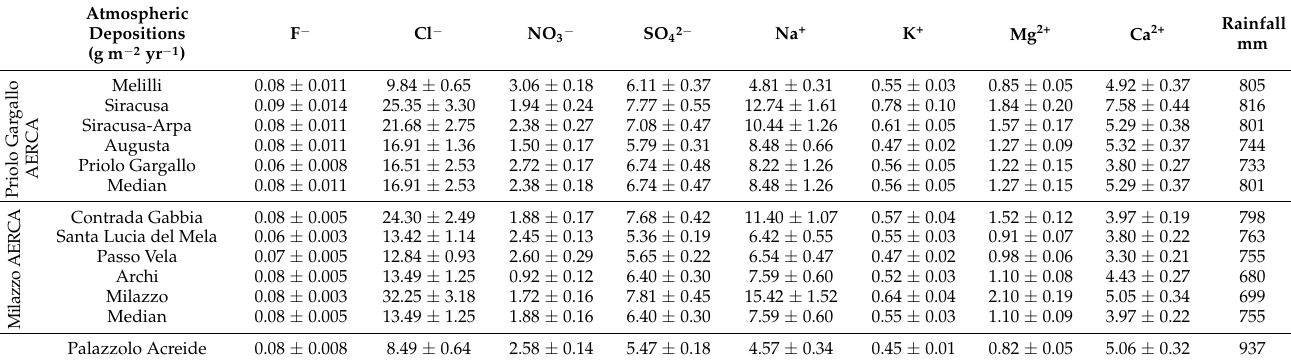
Table 4. Calculated annual atmospheric depositions (g m − 2 yr − 1